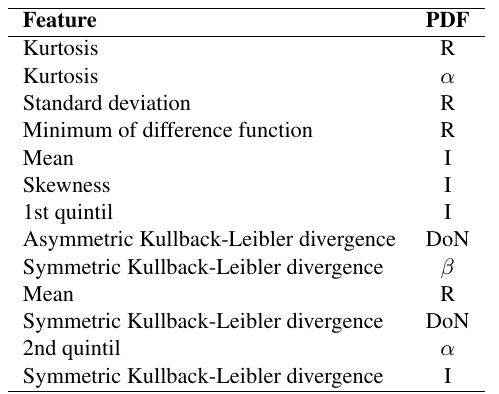
Figure 10. Impact of varying dormer widths (left) on the PDF of residuals (right).